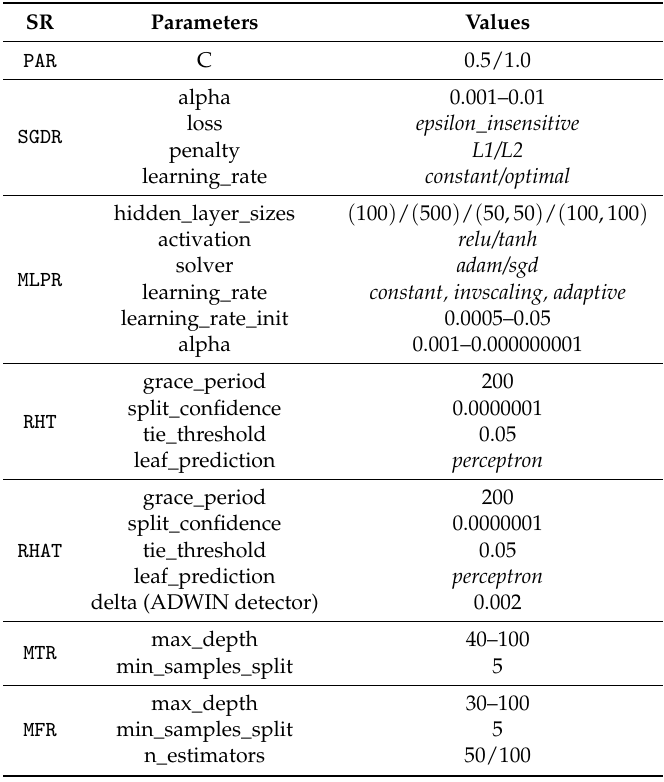
Table 11. Hyper-parameter tuning results for SRs in the experiment